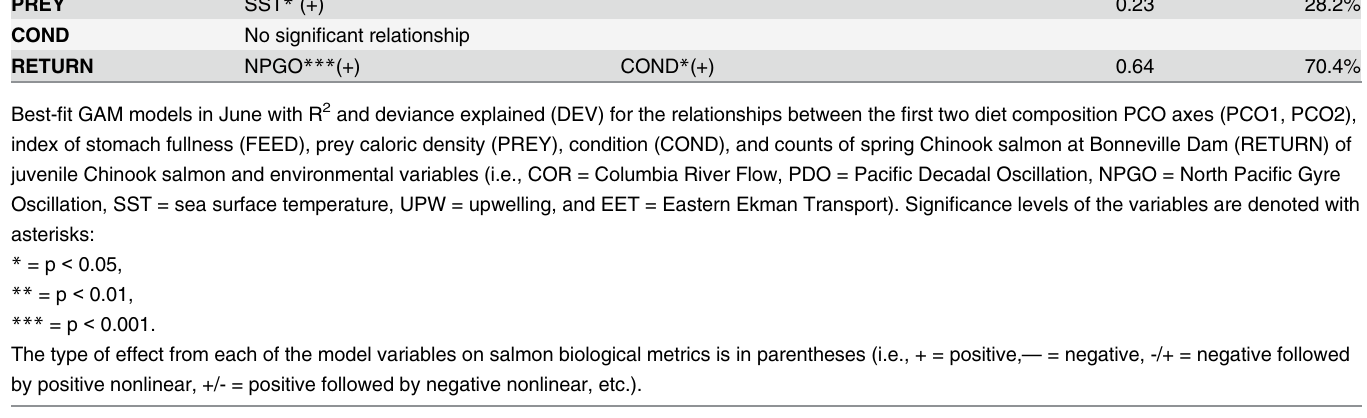
Table 3. General additive models of June salmon biological and environmental variables. Variable